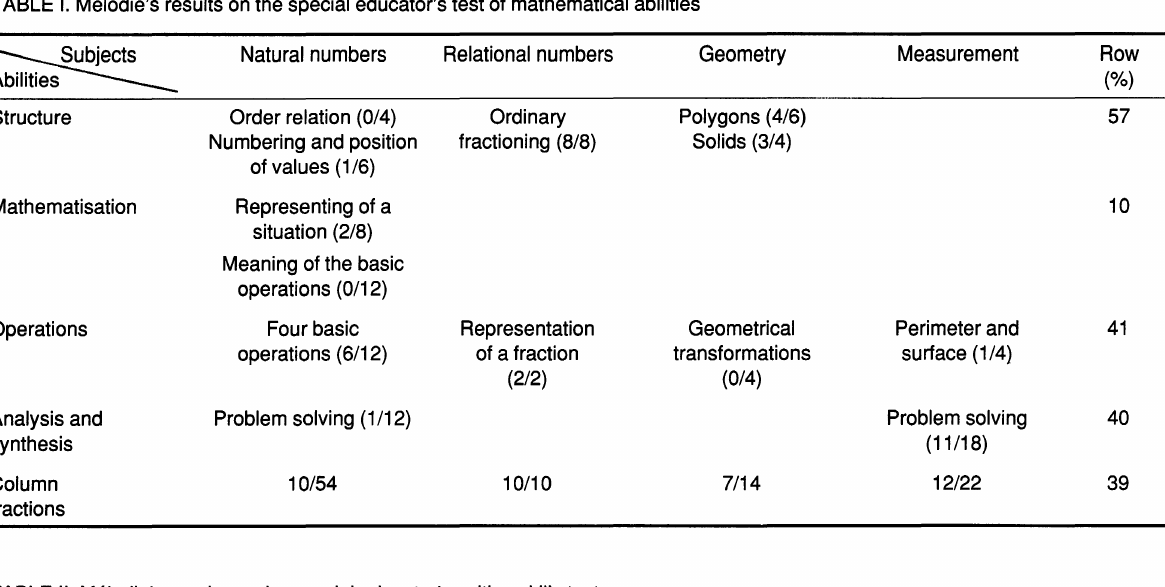
TABLE I. Melodie's results on the special educator's test of mathematical abilities